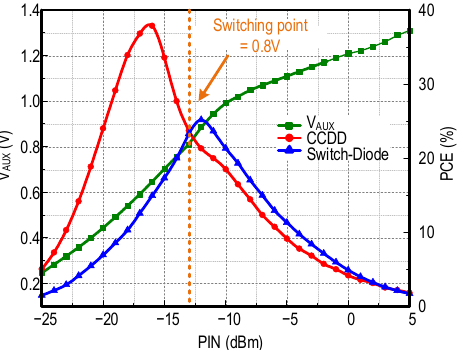
Figure 6. Relationship between input power, auxiliary charge pump voltage, and the switching point of the rectifier’s topology.